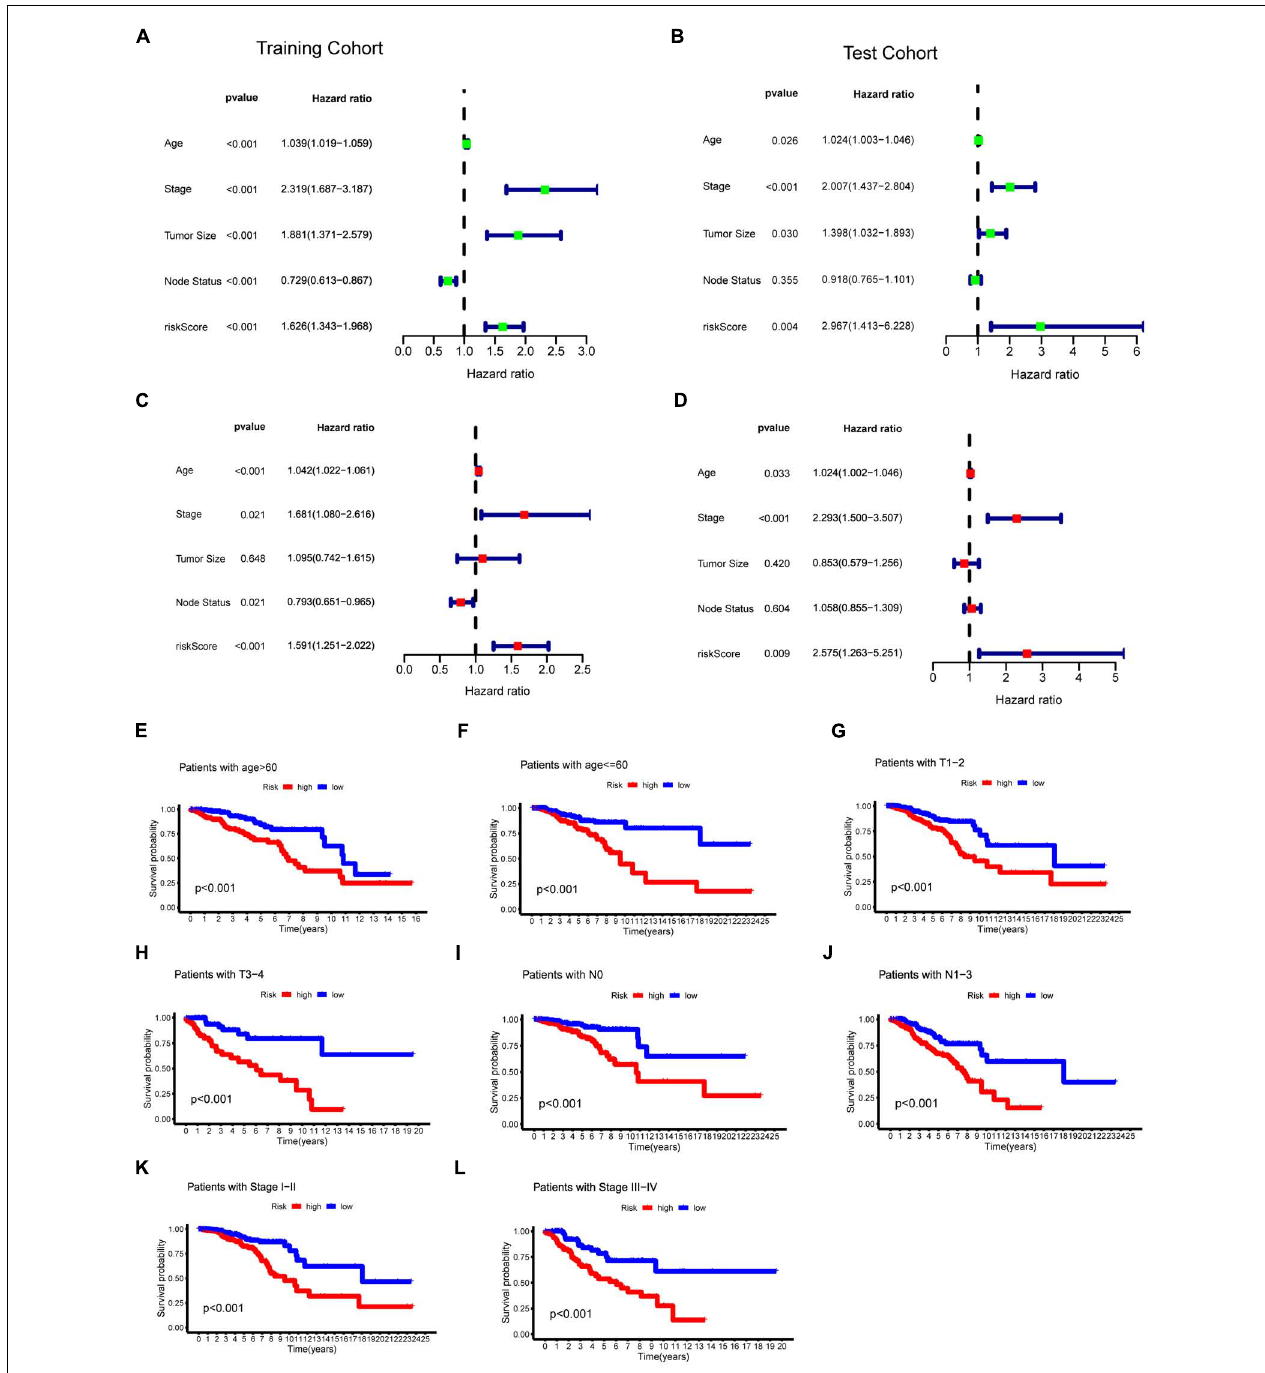
FIGURE 6 | Evaluation of the prognostic role of m6ALncM signature. (A,B) The univariate Cox forest map of risk model score and clinical features in the TCGA training cohort (A) and TCGA test cohort (B) . (C,D) The multivariate Cox forest plot of risk model score and clinical characteristics in the training cohort (C) and test cohort (D) . (E–L) The m6A-LncRM signature retained its prognostic value in multiple subgroups of BC patients. Survival analysis in low- and high-risk groups adjusted by clinical factors including age, tumor size, node status, and tumor stage.